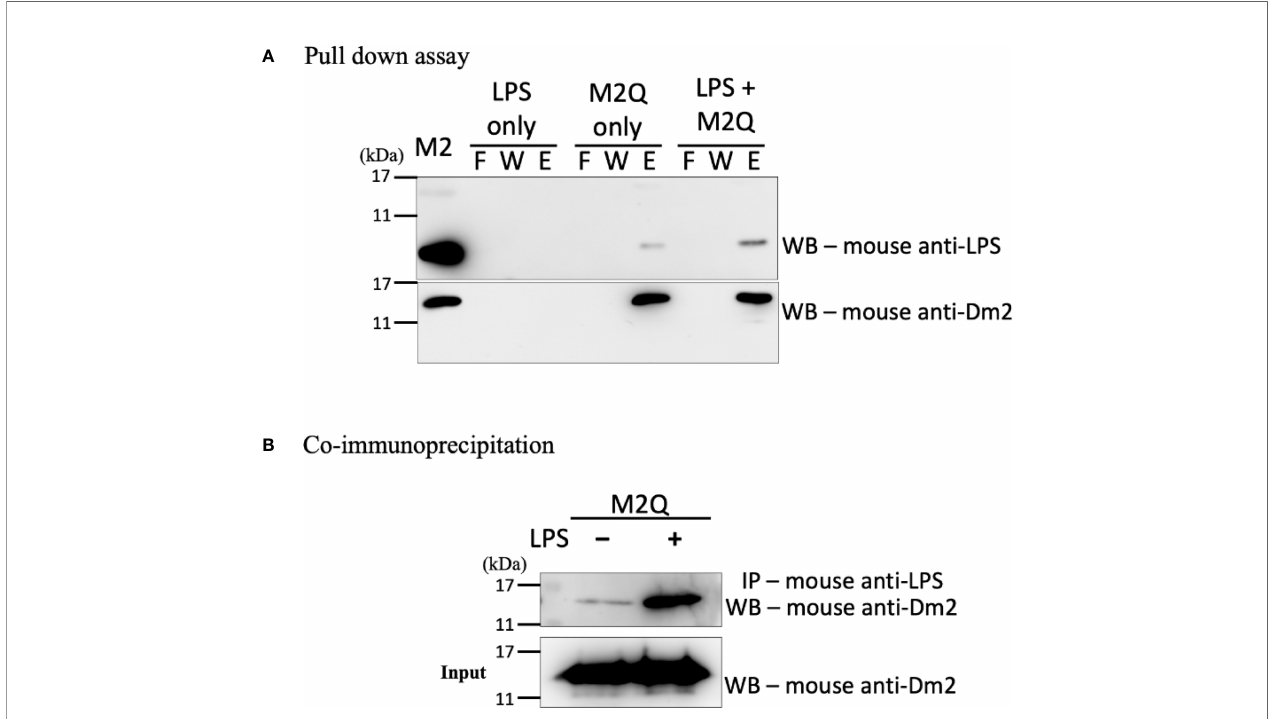
FIGURE 3 | The interaction between recombinant Der m 2 protein and LPS. (A) The recombinant truncated Der m 2 protein after purifying with Q column (M2Q) was immobilized on Ni-NTA resin and then incubated with LPS for pull-down assay. The fractions of the pull-down assay were further analyzed by Western blot by using anti-LPS antibodies. The endogenous LPS signal is more apparent in the elution when LPS is present, and the signal in the elution of M2Q only should be the endogenous LPS. The Western blot using anti- Der m 2 antibodies is to con fi rm the M2Q proper binding and quantity. The puri fi ed recombinant Der m 2 before Q column (M2) was shown in the fi rst lane. F, fl ow through; W, wash; E, elution. (B) The co-immunoprecipitation (Co-IP) assay used anti-LPS antibody to precipitate LPS and further analyzed by Western blot to detect the M2Q presence. The M2Q signal is dramatically increased when LPS is present.